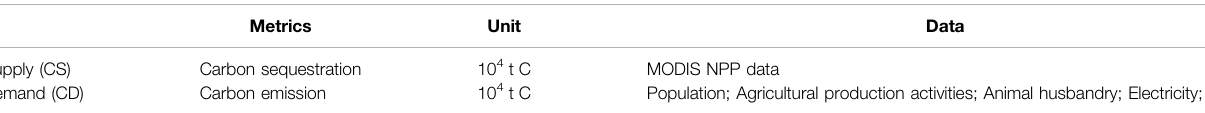
TABLE 2 | Datasets for mapping the supply and demand of carbon